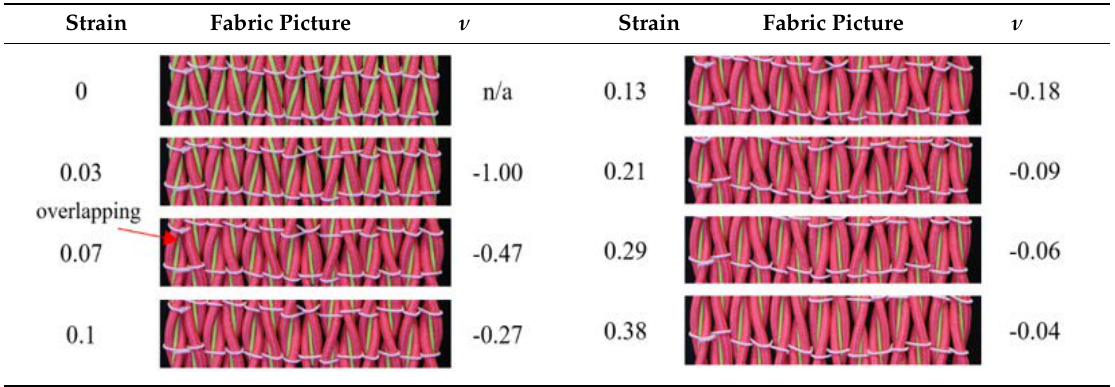
Table 4. Pictures and PR values of sample F3 at different extension levels.